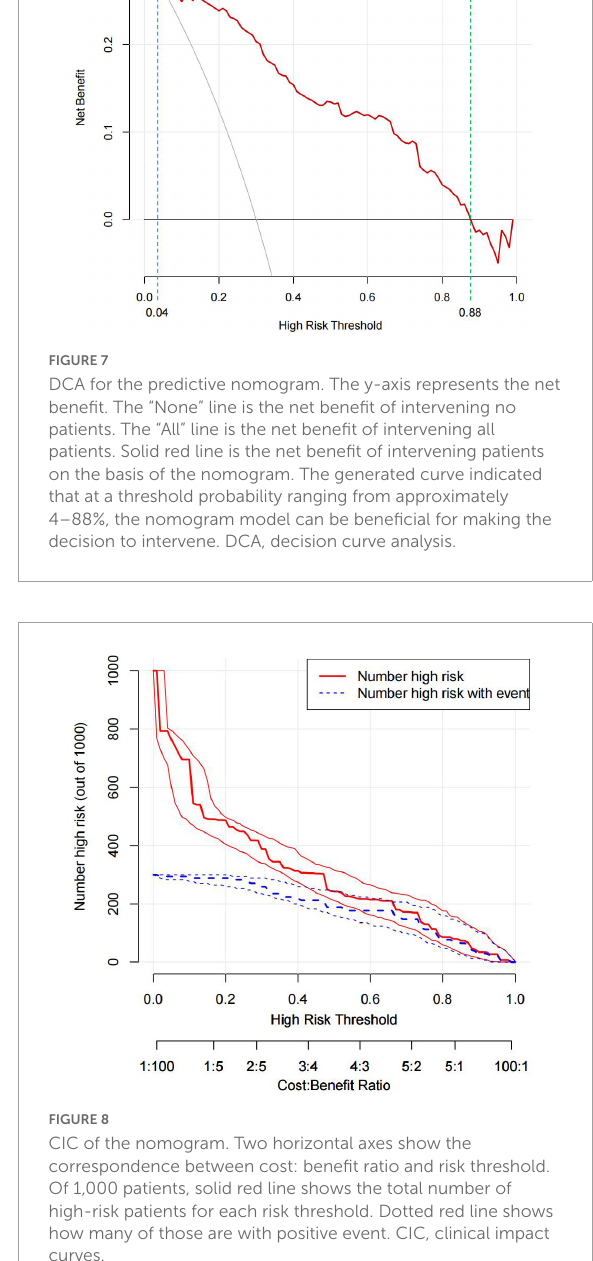
levels were independent predictors of in-hospital mortality (30).